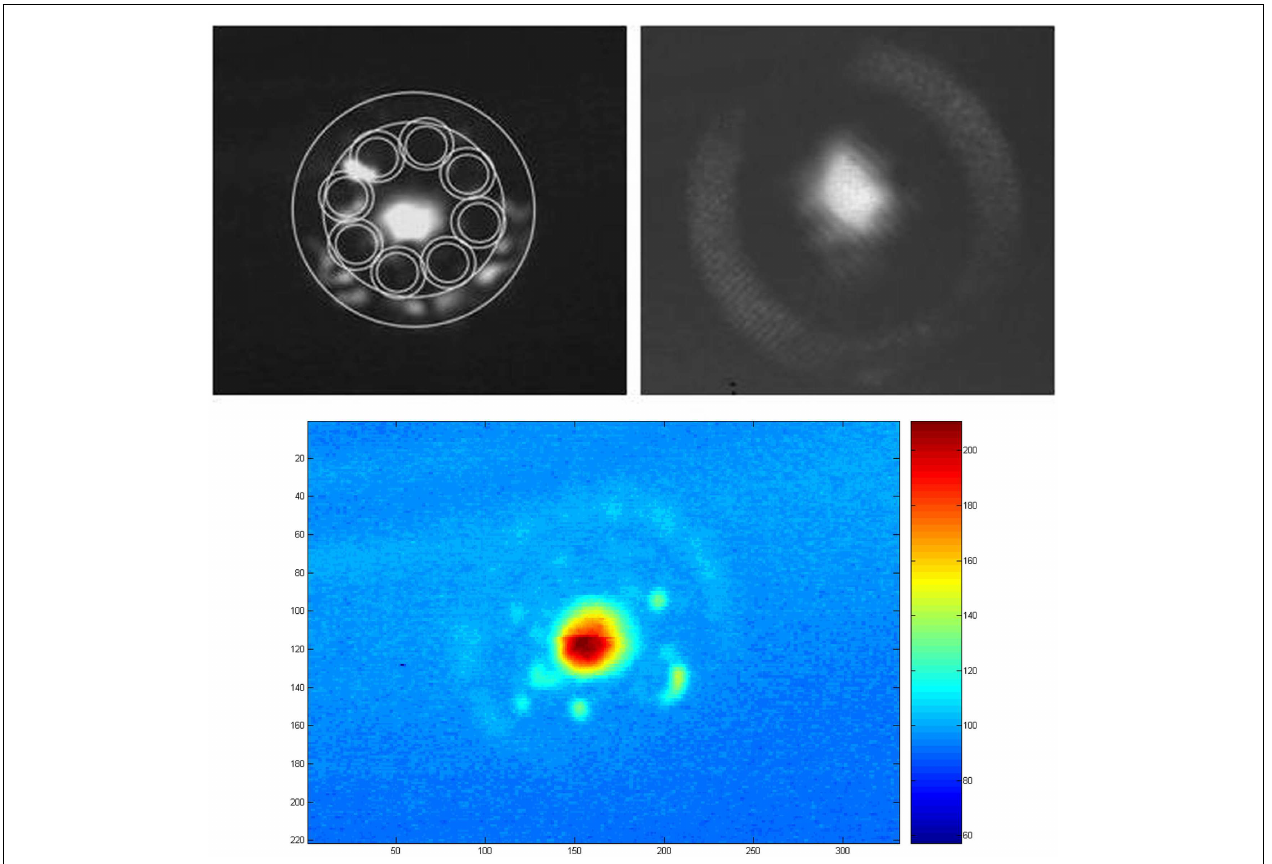
FIGURE 14 | Intensity distribution of CO 2 -laser radiation over the fiber cross-section (Kosolapov et al., 2011)